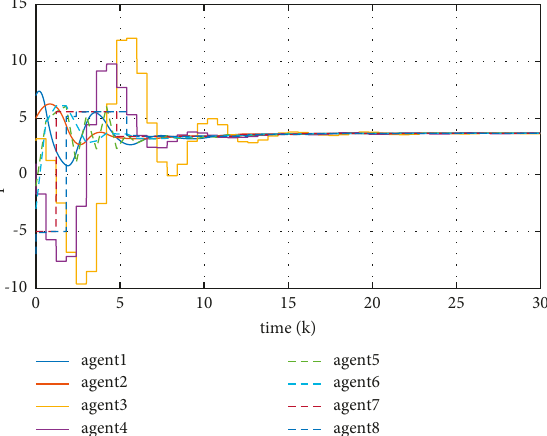
Figure 2: Position of the dynamic agents.